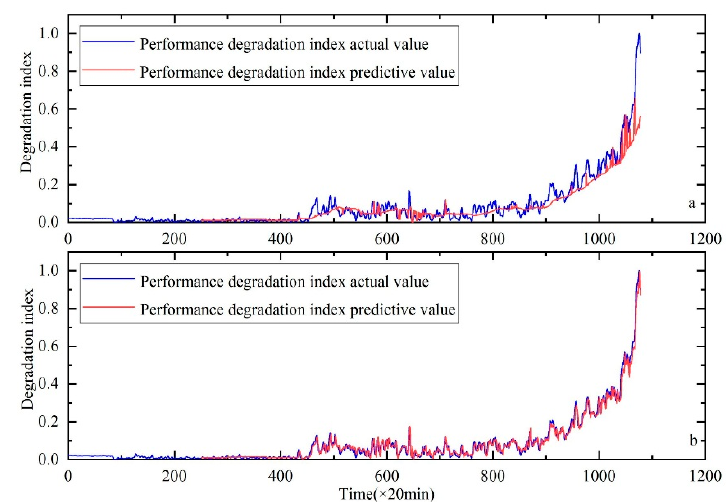
Figure 12. Performance degradation prediction of bearing 3, ( a ) is the result of HKF–SVR with parameters optimized by the GA and ( b ) is the result of HKF–SVR with parameters optimized by KH.